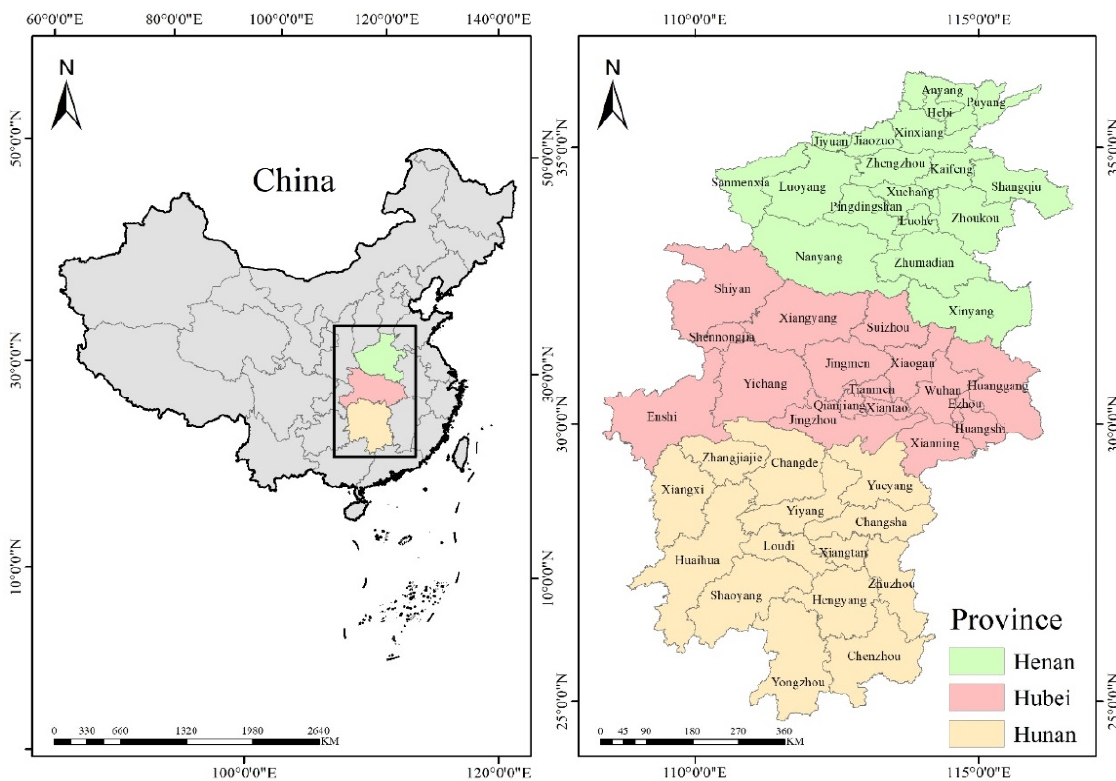
Figure 1. Regional geographic locations distribution map of APIIU research.